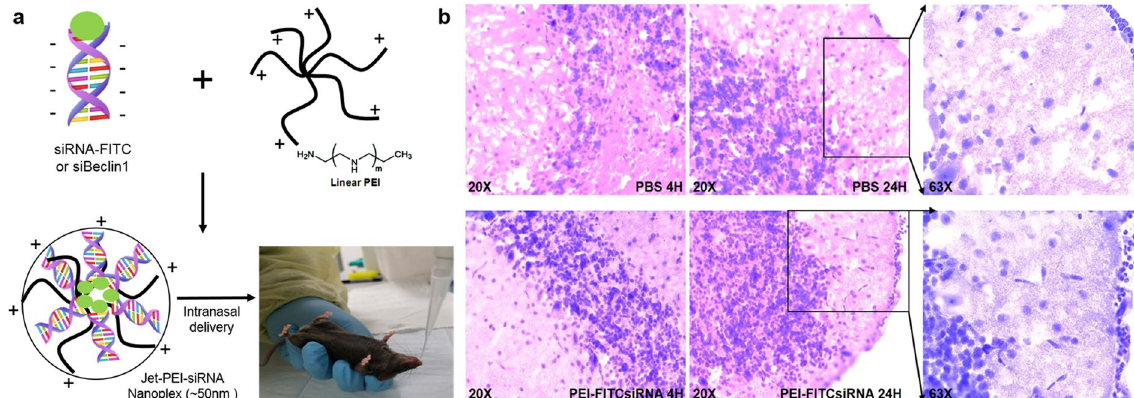
Figure 1. PEI-siRNA formulation and mouse brain histology after intranasal administration of nanoplexes. ( A ) Schematic representation of the PEI-siRNA formulation and intranasal administration to adult C57BL/6 J mice (n = 3/treatment). ( B ) Representative images of Hematoxylin-eosin stained sections of brain tissues after 4 hours (at 20X magnification) and 24 hours of intranasal administration of PBS (upper panel) and PEI- FITCsiRNA (lower panel) at 20X and 63X